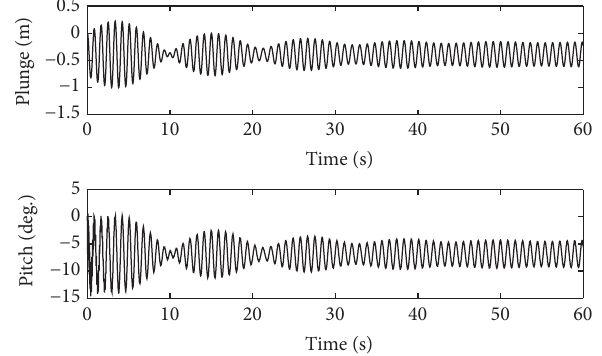
Figure 3: Pitch and plunge responses at moderate stall